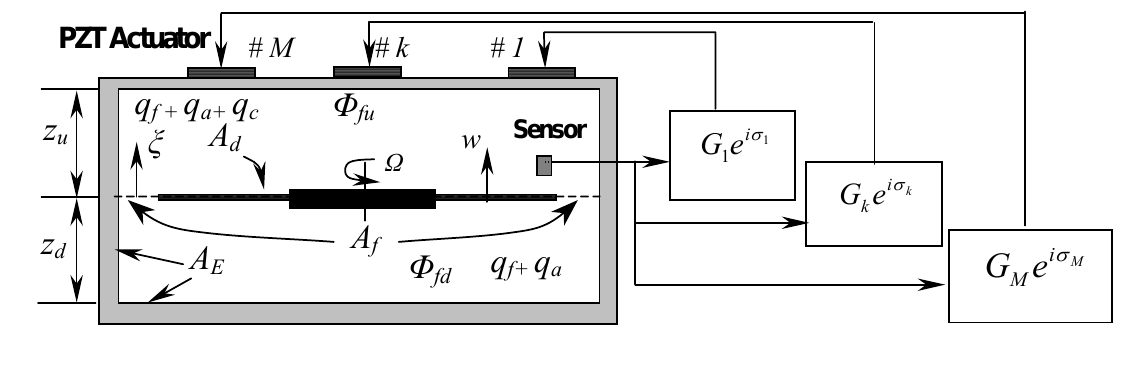
Figure 3. Schematic diagram of feedback control with